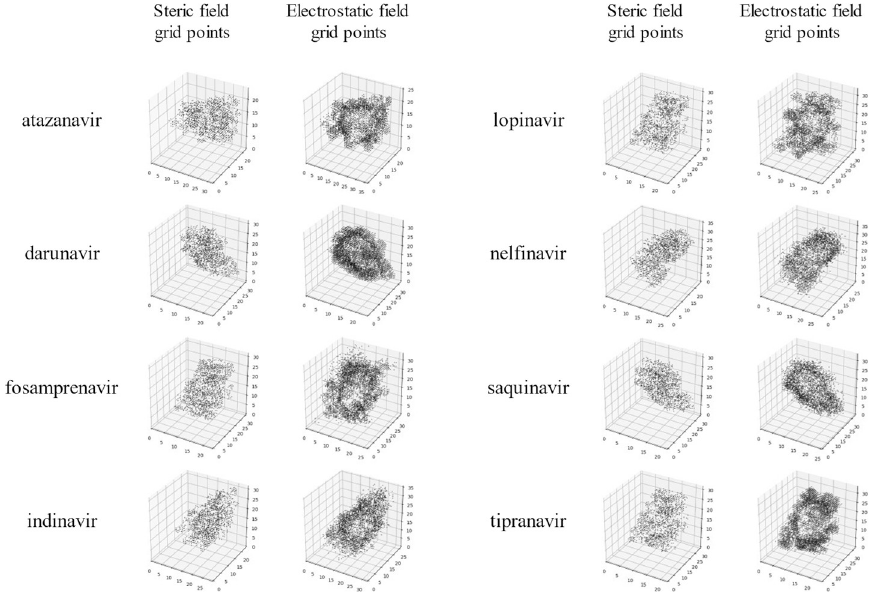
Fig 3. Selected grid points of steric (left) and electrostatic (right) molecular field parameters in the analysis of drug resistance for each HIV-1 protease inhibitor. The grid points were selected by preprocessing and SVR feature